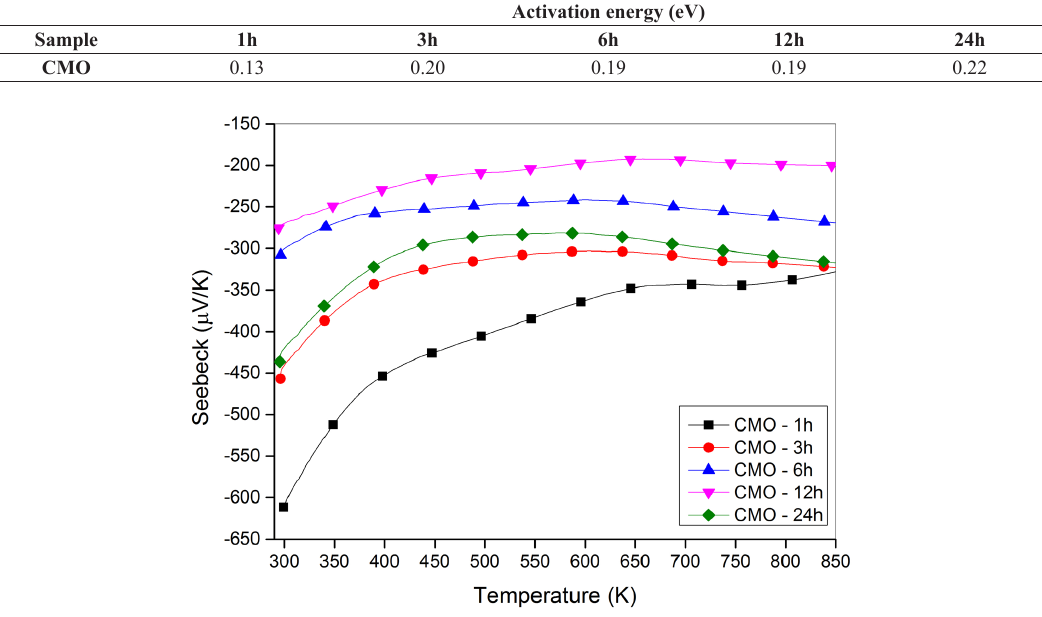
Figure 6. Seebeck coefficient values for the CMO